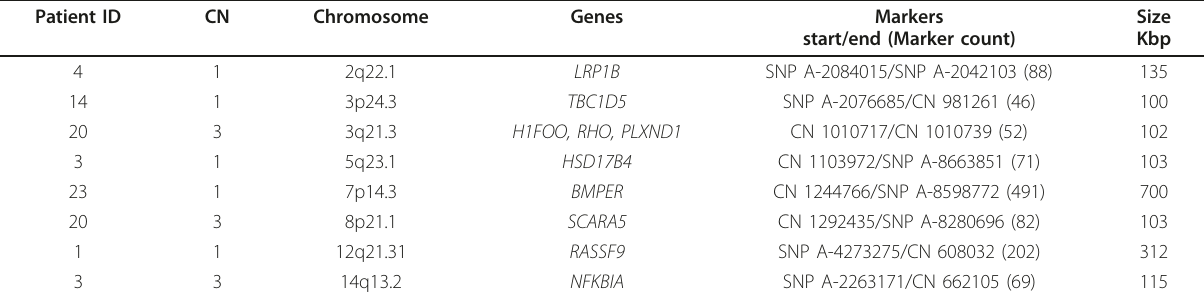
Table 2 Gene regions of rare copy number (CN) variation in patients with Addison ’ s disease detected by gene chip Patient